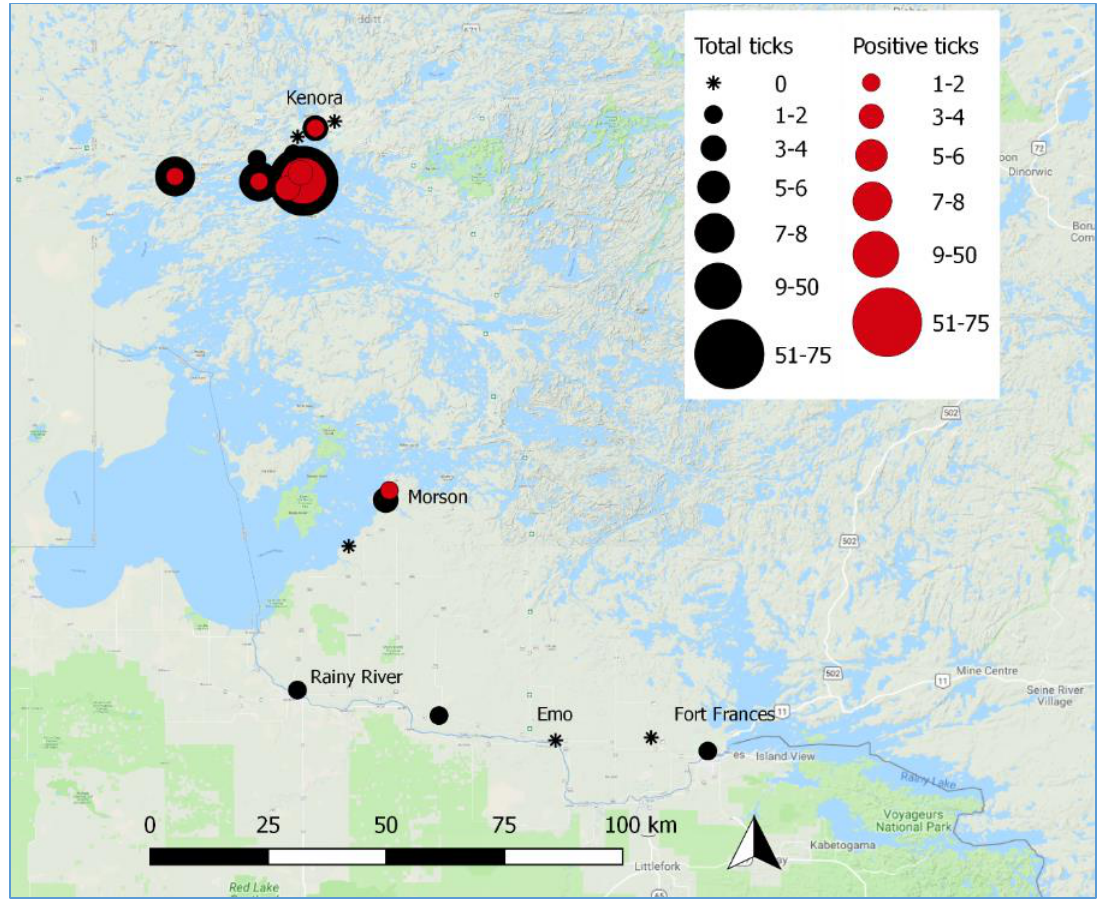
Figure 3. Locations of I. scapularis by B. burgdorferi -positivity in the NWHU catchment area based on location of active tick surveillance from 2014 to 2017.